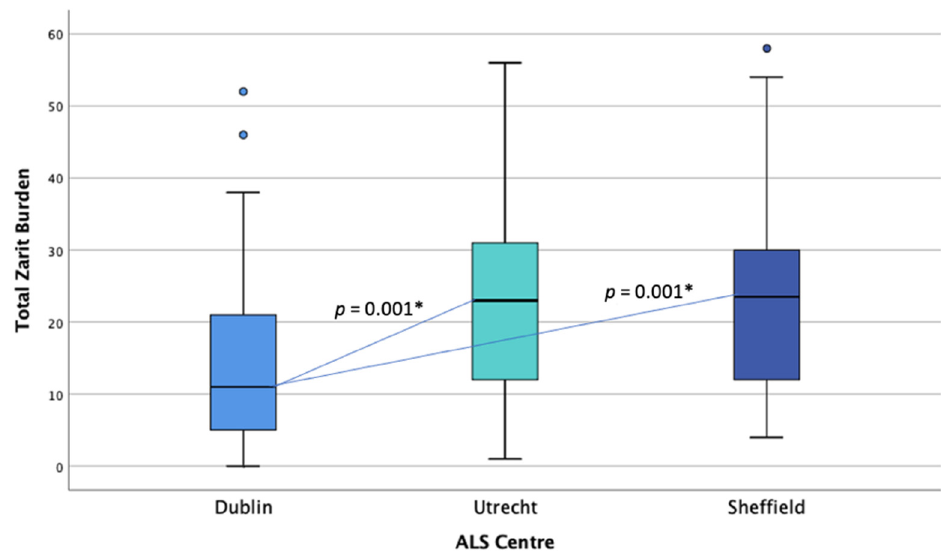
Figure 2. Distribution of burden (ZBI) scores across centres. * Statistical significance.